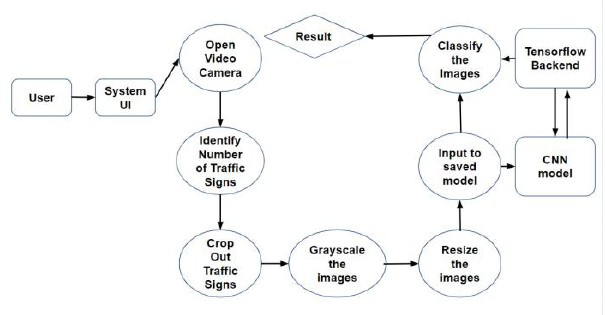
Fig. 6. Tail Function on GTSRB Dataset Fig. 5 and 6 show the details of the dataset by revealing the starting and ending 5 rows, respectively, as well as its characteristics. The dataset has 39208 rows and 8